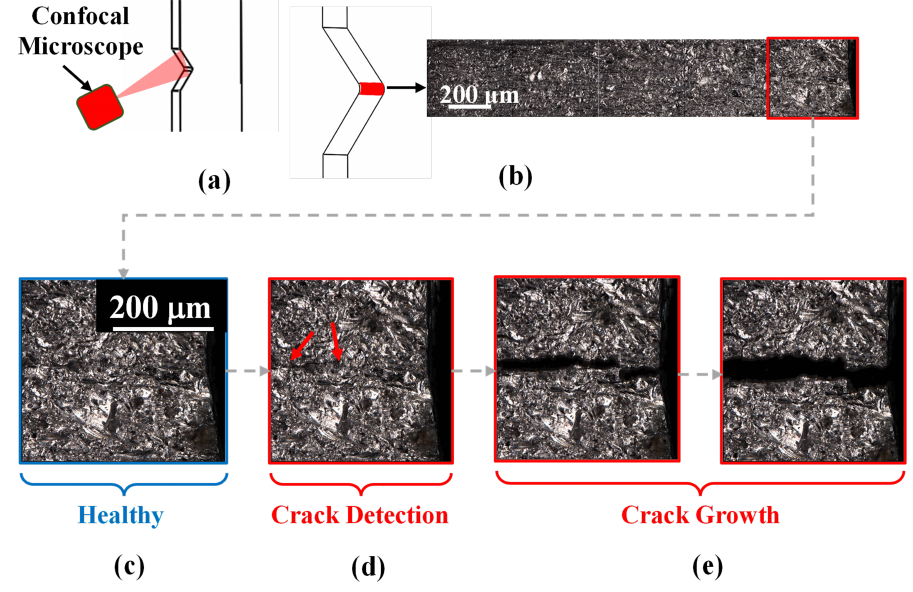
Figure 7. ( a ) A schematic showing the orientation of the confocal microscope. ( b ) A representative imaging of the region of high stress. ( c – e ) Damage progression through a part of the high-stress region in the healthy, crack detection, and crack growth stages, respectively.